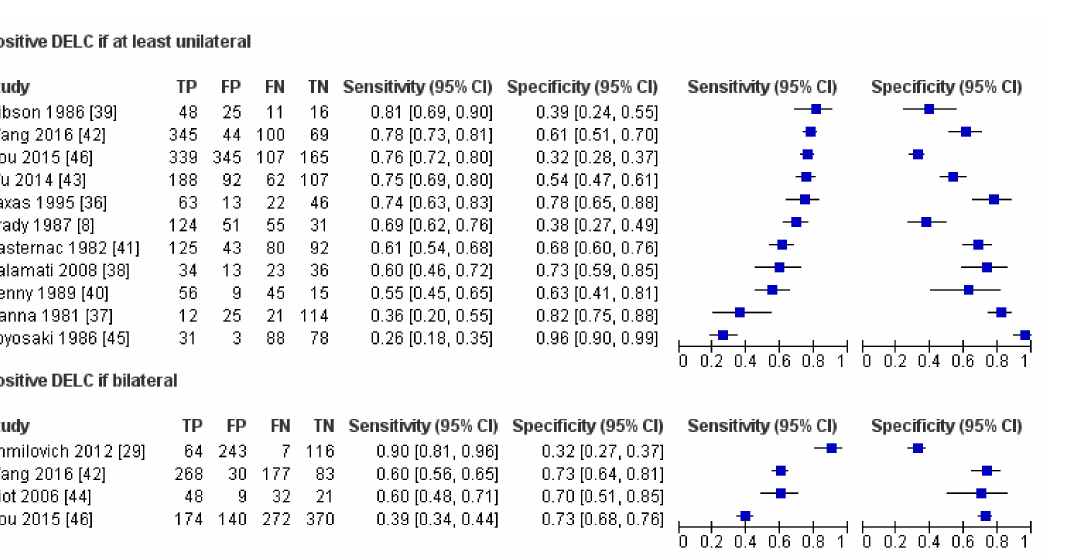
Figure 5. Results of individual studies and forest plot of sensitivity and specificity with 95% confidence